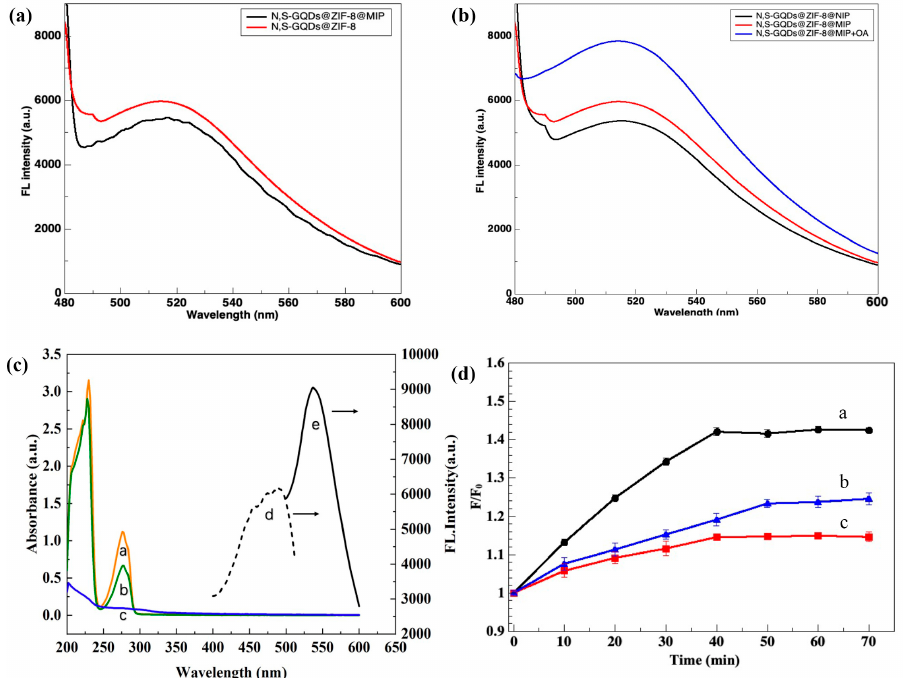
Figure 3. ( a ) Fluorescence spectra N, S-GQDs@ZIF-8 and N, S-GQDs@ZIF-8@MIP under 460nm ex- citation. The concentrations of N, S-GQDs@ZIF-8 and N, S-GQDs@ZIF-8@MIP were 1 mg mL − 1 . ( b )